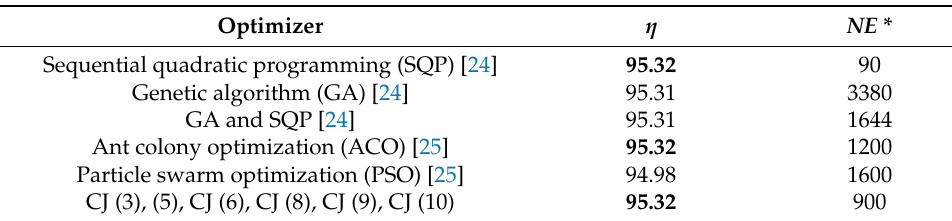
Table 6. Results of the optimizers for the brushless DC motor. Data in bold font indicates the larger values. Optimizer η NE * Sequential quadratic programming (SQP) [24] 95.32 90 Genetic algorithm (GA) [24] 95.31 3380 GA and SQP [24] 95.31 1644 Ant colony optimization (ACO) [25] 95.32 1200 Particle swarm optimization (PSO) [25] 94.98 1600 CJ (3), (5), CJ (6), CJ (8), CJ (9), CJ (10) 95.32